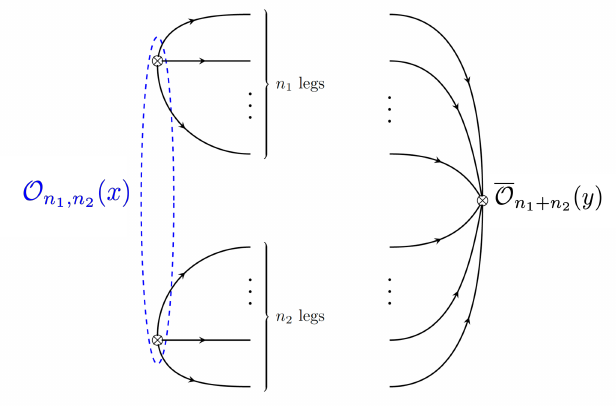
Figure 5 . Graphical representation of the chiral operator O n of legs corresponding to its two traces, and of the anti-chiral operator O n